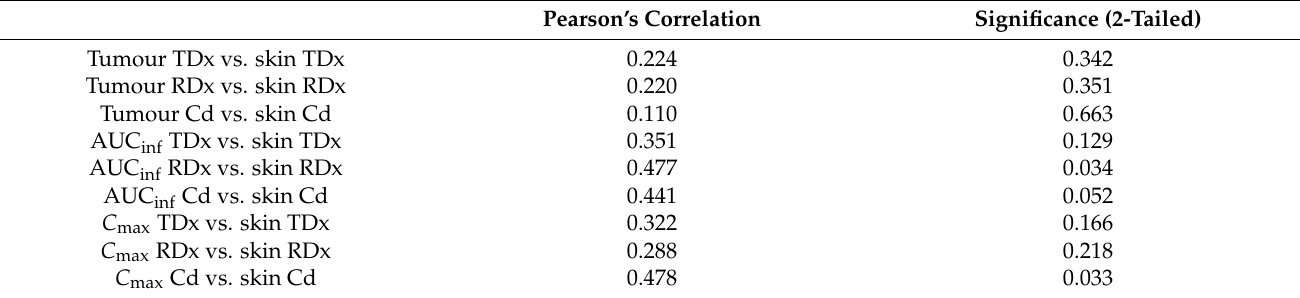
Table 2. Pearson’s correlation for docetaxel concentration in the tumour versus the skin; plasma docetaxel pharmacokinetics versus skin docetaxel